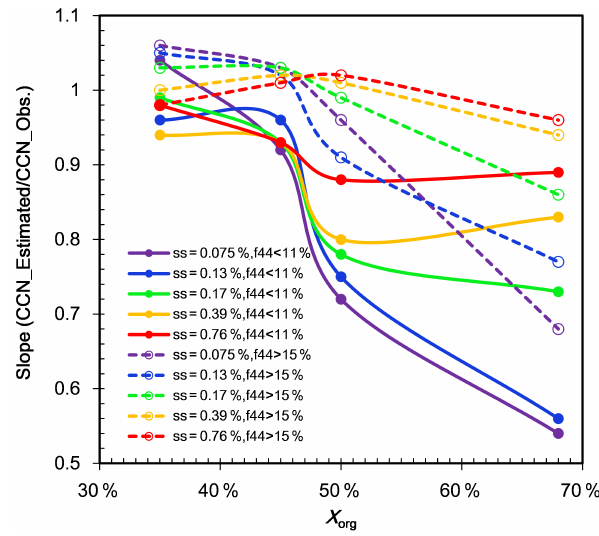
Figure 6. Slopes of the linear fit of estimated and observed N CCN dependence on volume fraction of organics ( x org ) at f 44 <11 and f 44 >15% for different supersaturation levels. Mean values of the hygroscopic parameter κ chem at f 44 <11% when x org >60%, 50%< x org <60%, 40%< x org <50%, and x org <40% are 0.27, 0.34, 0.40, and 0.46, respectively, while at f 44 >15% the value in- creased to 0.36, 0.42, 0.46, and 0.50,